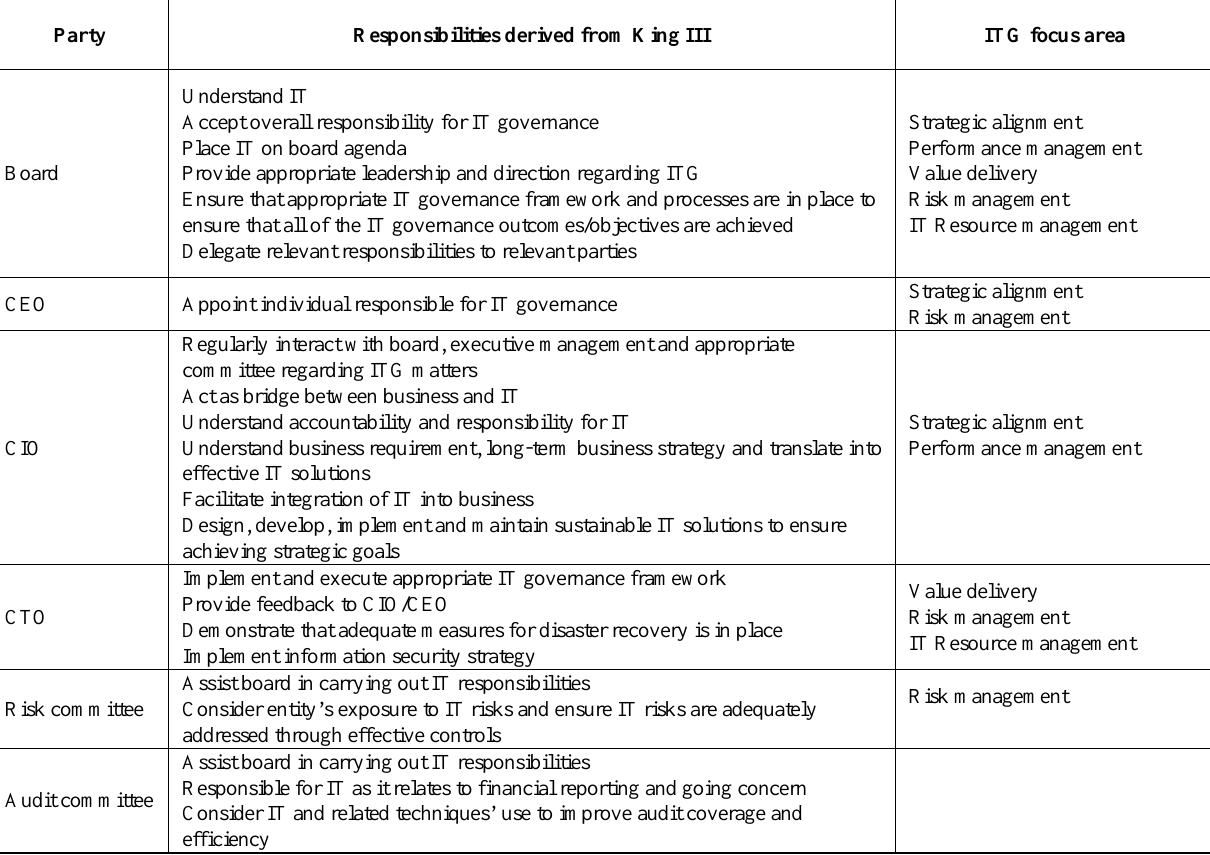
Table 4: King III roles and typical responsibilities regarding ITG